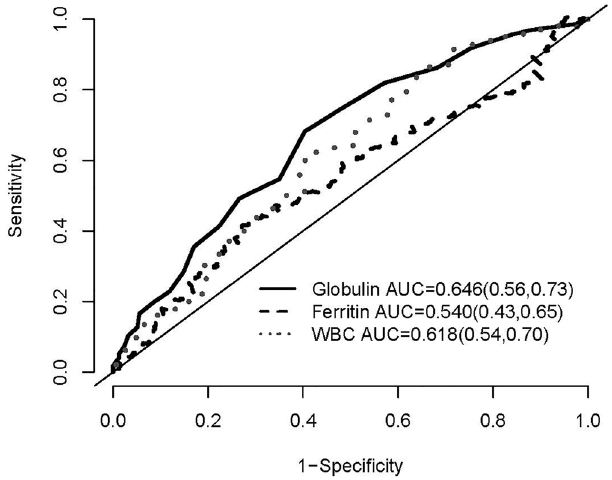
Figure 4. The area under the curve (AUC) by the Receiver Operating Characteristics (ROC) curve analysis of the overall all-cause mortality for globulin, ferritin, and WBC counts. Numbers in parentheses indicate 95% confidence